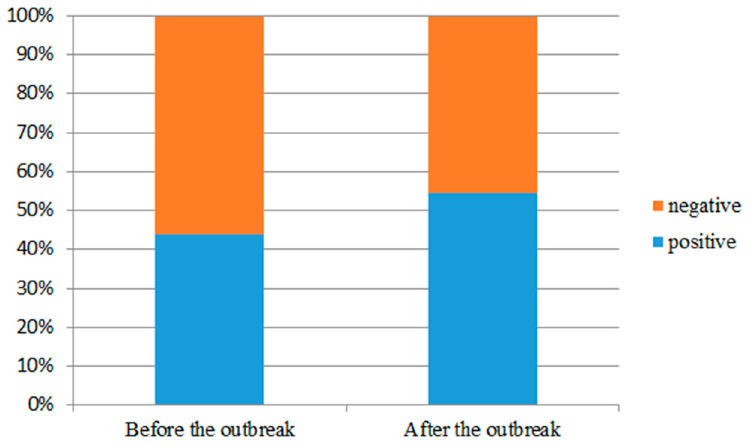
Figure 6. The proportion of emotional tendency before and after COVID-19.